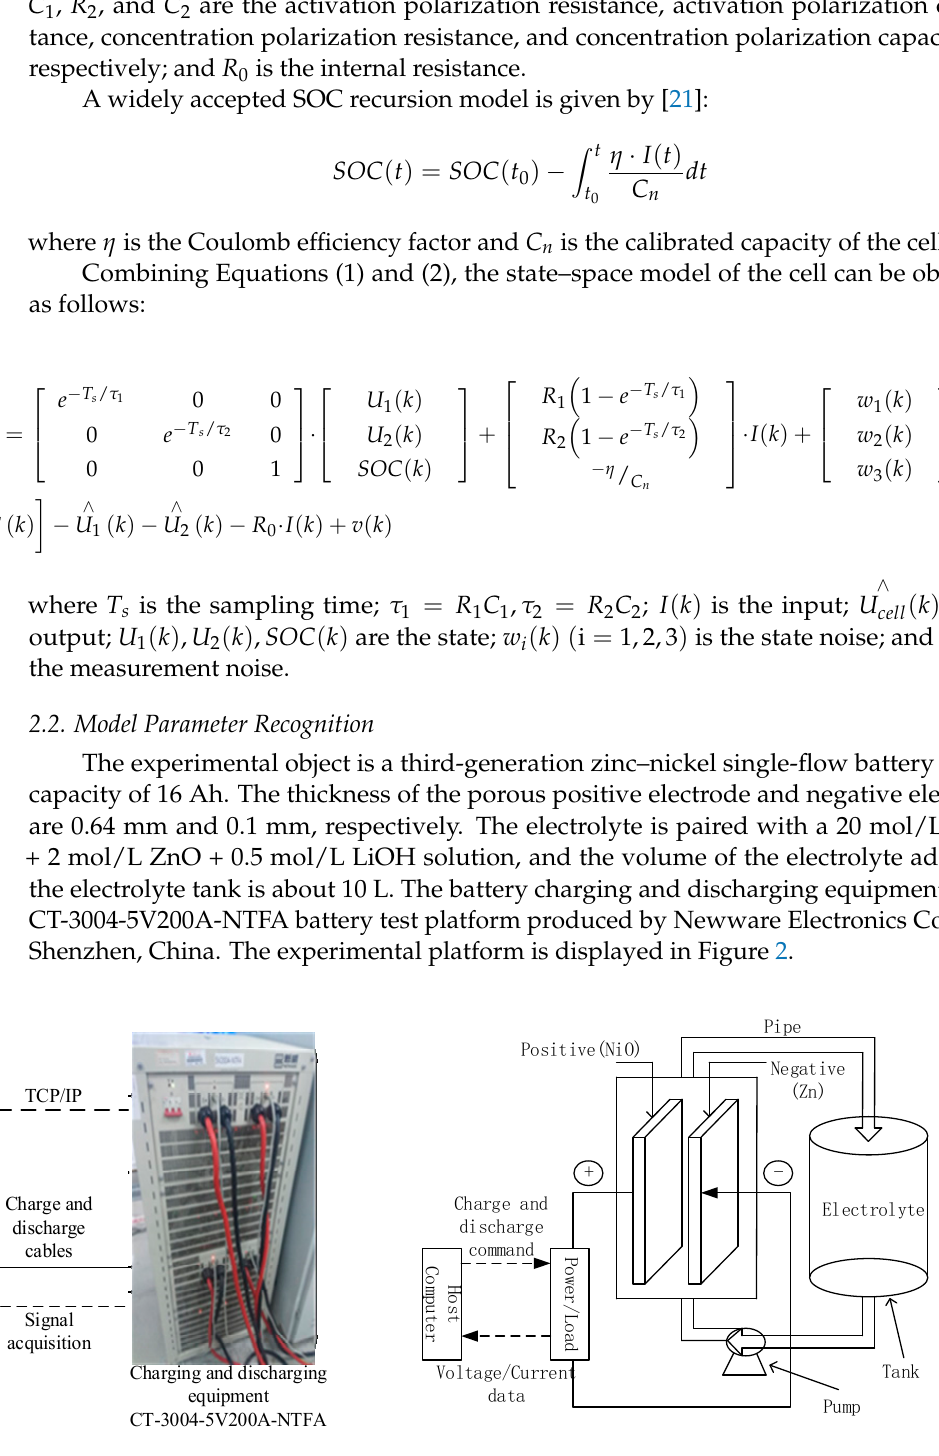
Figure 3. Discharge processes of the 0.75 C-rate constant pulse. The U oc - SOC look-up table can be obtained by the pulse data above, and determined as a sixth-order polynomial expression. The fitted curve is shown in Figure 4. 6 0 ( are the polynomial coefficients to fit the nonlinear correlation. Figure 4. Open circuit voltage fitting curve. 0